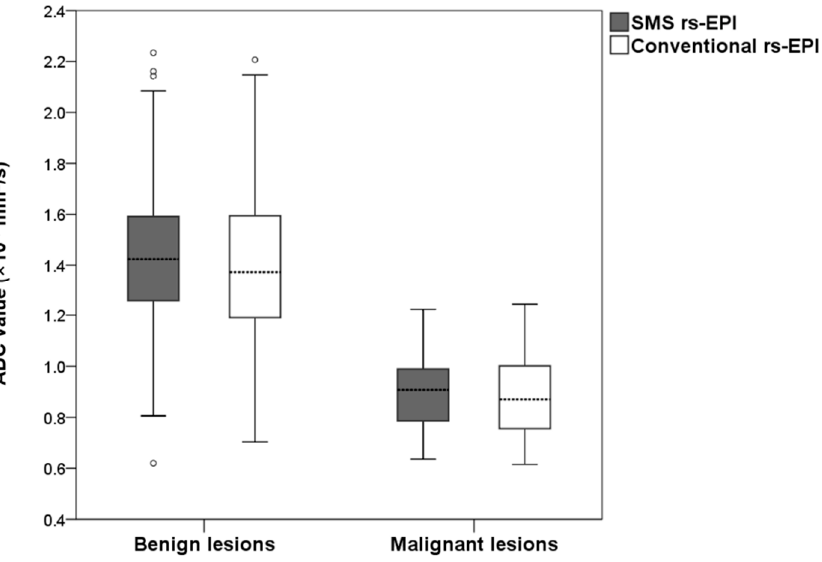
Figure 5. Boxplot of the ADC values of malignant and benign lesions for SMS rs-EPI and conventional rs-EPI.